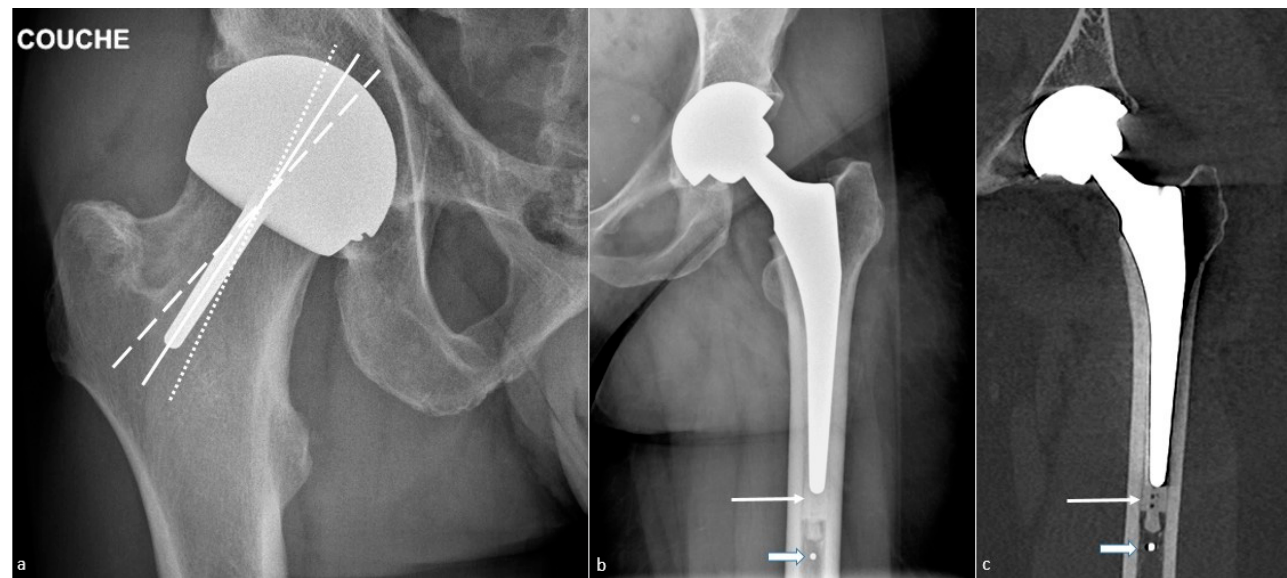
Figure 1. Total hip arthroplasties. A resurfacing arthroplasty is shown on ( a ) an antero-posterior hip radiograph and a conventional arthroplasty on ( b ) an antero-posterior hip radiograph and ( c ) a frontal CT-scan reformat. On ( a ), note the neutral position of the stem of the femoral component (white line). One should consider that slight valgus can be tolerated (little-dotted white line) and that varus positioning should not occur (large-dotted white line). On ( b , c ), also note the cement (thin arrow) and a metallic marker at the distal part of a cement restrictor (thick arrow).